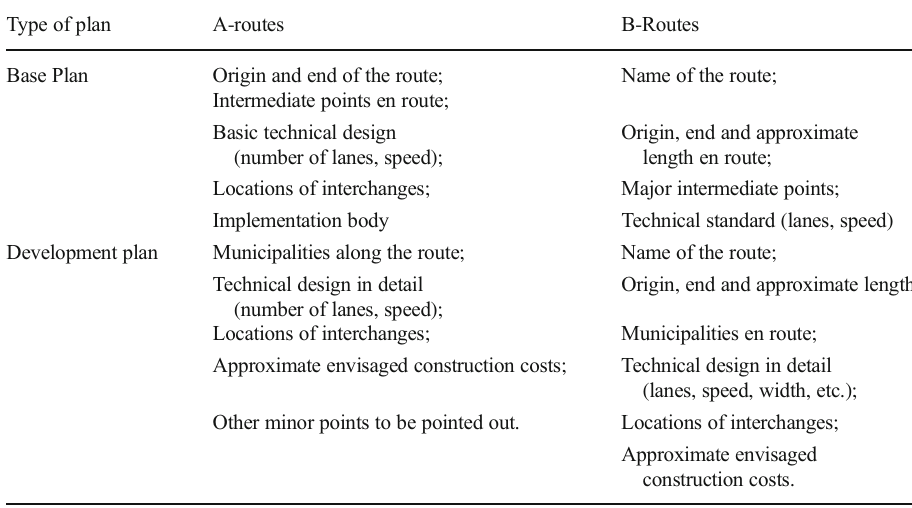
Table 4 Overview of the contents of the base and development plans of A-Route and B-Route expressways, Source: